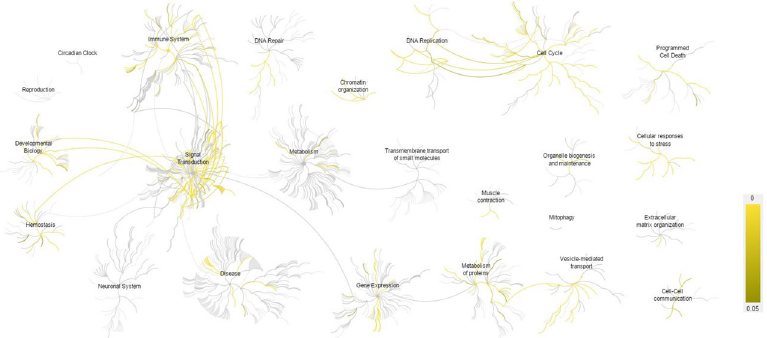
Figure 2. Main groups and hierarchical relationship of Reactome pathways. Reactome pathways are classi fi ed into different groups based on the similarity of their biological functions. The bottom color gradation provides the P value comparison for signi fi cant pathways. The dendritic structure represents the hierarchical relation of pathways.